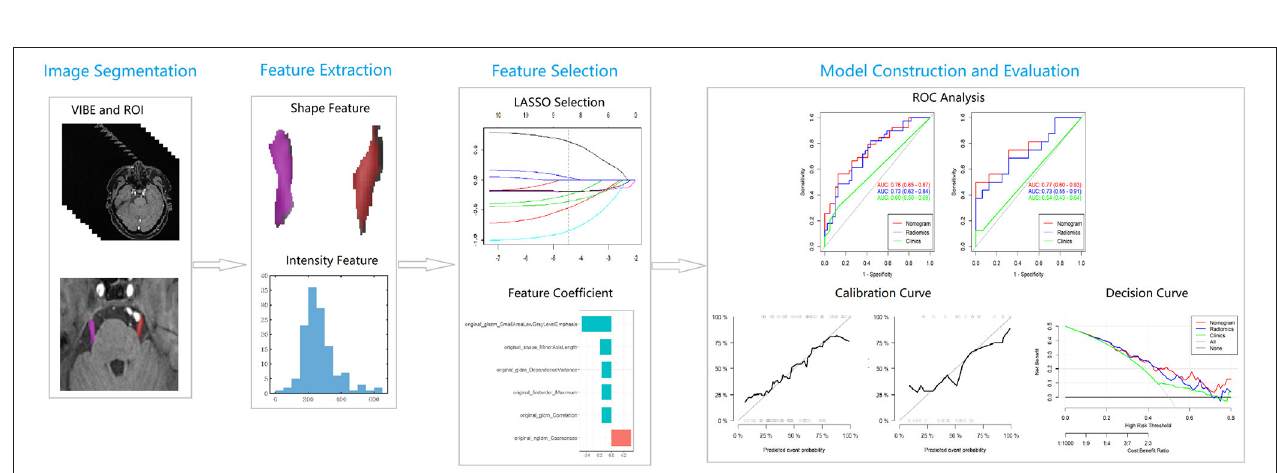
FIGURE 2 | A flowchart of radiomics analysis. LASSO, least absolute shrinkage and selection operator; ROC, receiver operating characteristic